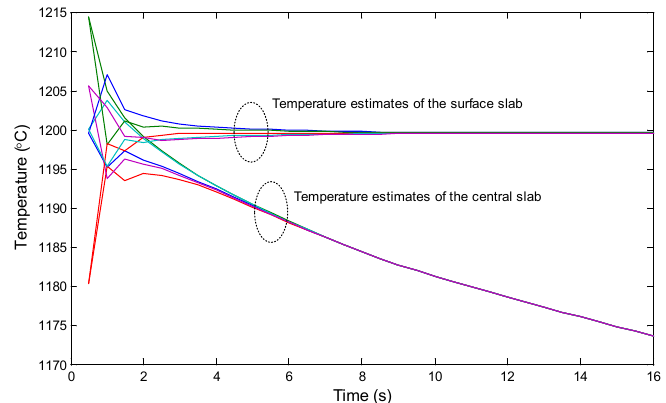
Figure 6. The surface and central temperature estimates by different nodes during transfer of the slab into the interstand section.